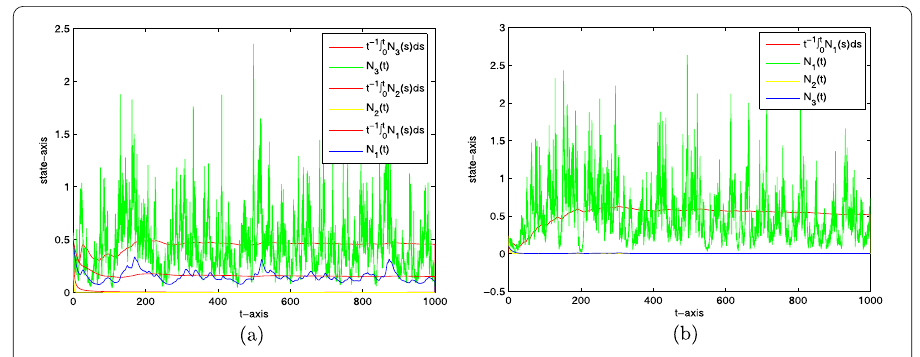
Figure 3 Dynamical behavior of (1.2). ( a ) is for system (1.2) with ξ 1 = 0.4, ξ 2 = 0.8, ξ 3 = 0.01, then N 2 ( t ) is extinct, and lim t →∞ (cid:8) N 1 ( t ) (cid:9) = 0.1671, lim t →∞ (cid:8) N 3 ( t ) (cid:9) = 0.5123. ( b ) is for system (1.2) with r 3 = 0.1, ξ 1 = 0.469, ξ